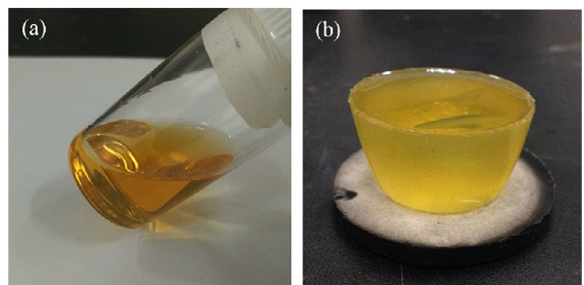
Fig. 2 Optical images of PMVBSZ after treatment at 120 /2 h: (a) without DCP and (b) with DCP added. ℃